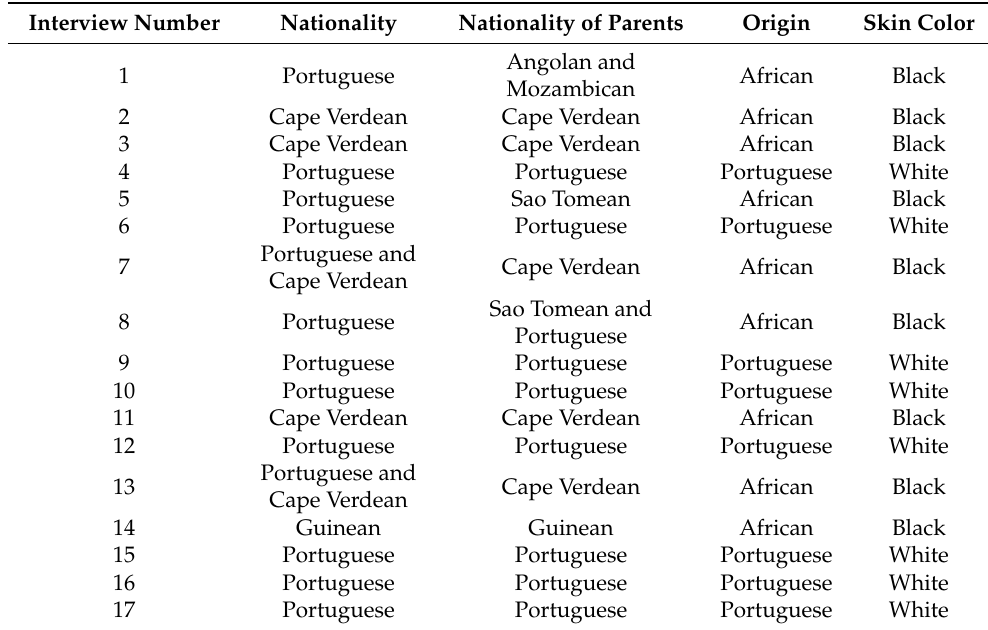
Table 1. Characterization of the origin, skin color and nationality of the